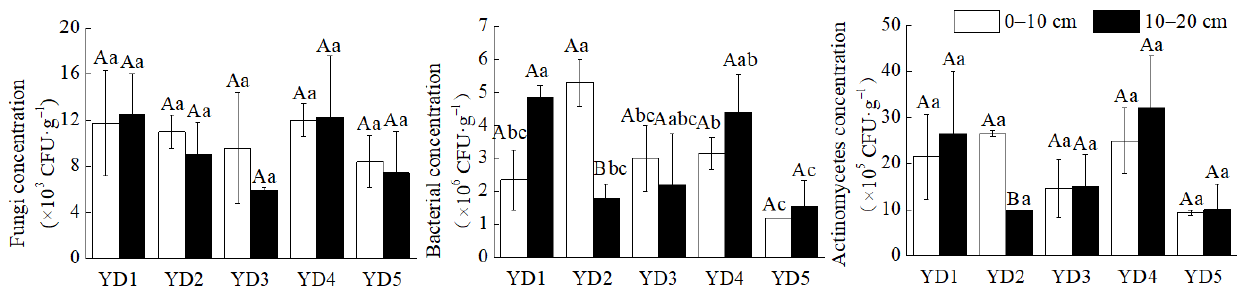
Figure 3. Concentration of soil microorganisms of Z. planispinum plantations. Lower case letters, significant differences between different plantation types of the same depth at p < 0.05; upper case letters, significant differences between different depths of the same plantation types at p < 0.05. In the 0–10 cm soil layer, microbial biomass P (MBP) in plot 4 was significantly higher than in plots 1 and 5, and there was no significant difference in microbial biomass C (MBC) and microbial biomass N (MBN) among the five plots. In the 10–20 cm soil layer, MBC was significantly higher in plot 4 than in plot 1, and there were no significant differences in MBN and MBP among the five plots. The results showed that MBN was more stable than MBC and MBP, and that plantation type had little effect on MBC and MBP. There were no significant differences in MBC:MBN and MBN:MBP between the two soil layers; in the 0–10 cm layer, MBC:MBP in plot 1 (1.95) was significantly higher than in plots 2–4 (1.77, 1.71, and 1.72, respectively), and there were no significant differences in the 10–20 cm layer (Figure 4).